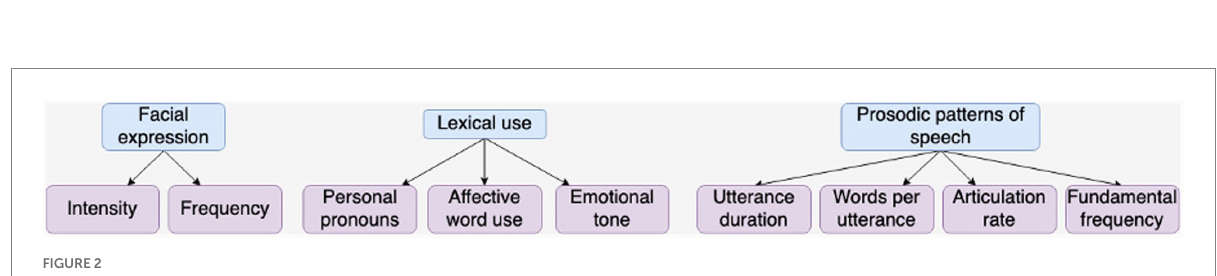
FIGURE 2 Relationship of affect/behavior measures to their dependent variables.